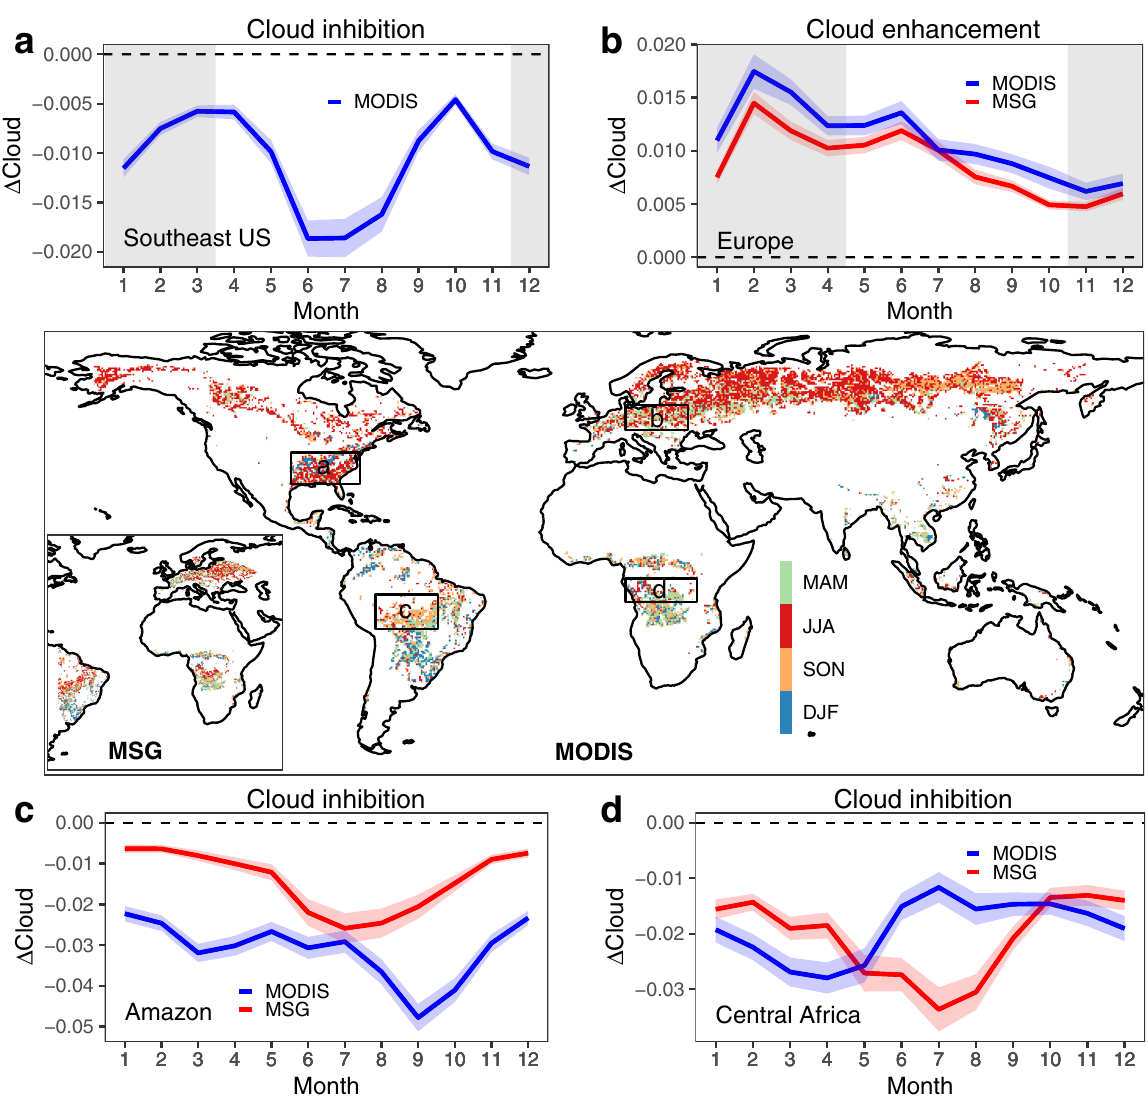
Fig. 2 Seasonal variations of the potential effects of forests on cloud cover. Months with the maximum magnitude of Δ Cloud for MODIS and MSG during the snow-free season are shown on the global map. MAM is March-April-May, JJA is June-July-August, SON is September-October-November, and DJF is December-January-February. Seasonal variations of Δ Cloud are shown in selected regions: a Southeast US (97°W to 75°W, 30°N to 40°N), b Europe (10°E to 30°E, 47°N to 55°N), c Amazon (70°W to 50°W, 16°S to 5°S), and d Central Africa (10°E to 33°E, 7.5°S to 0°) for MODIS and MSG. Months with snow cover are shown as the gray shaded areas in the background. The blue and red shaded areas denote the 95% con fi dence interval of Δ Cloud for MODIS and